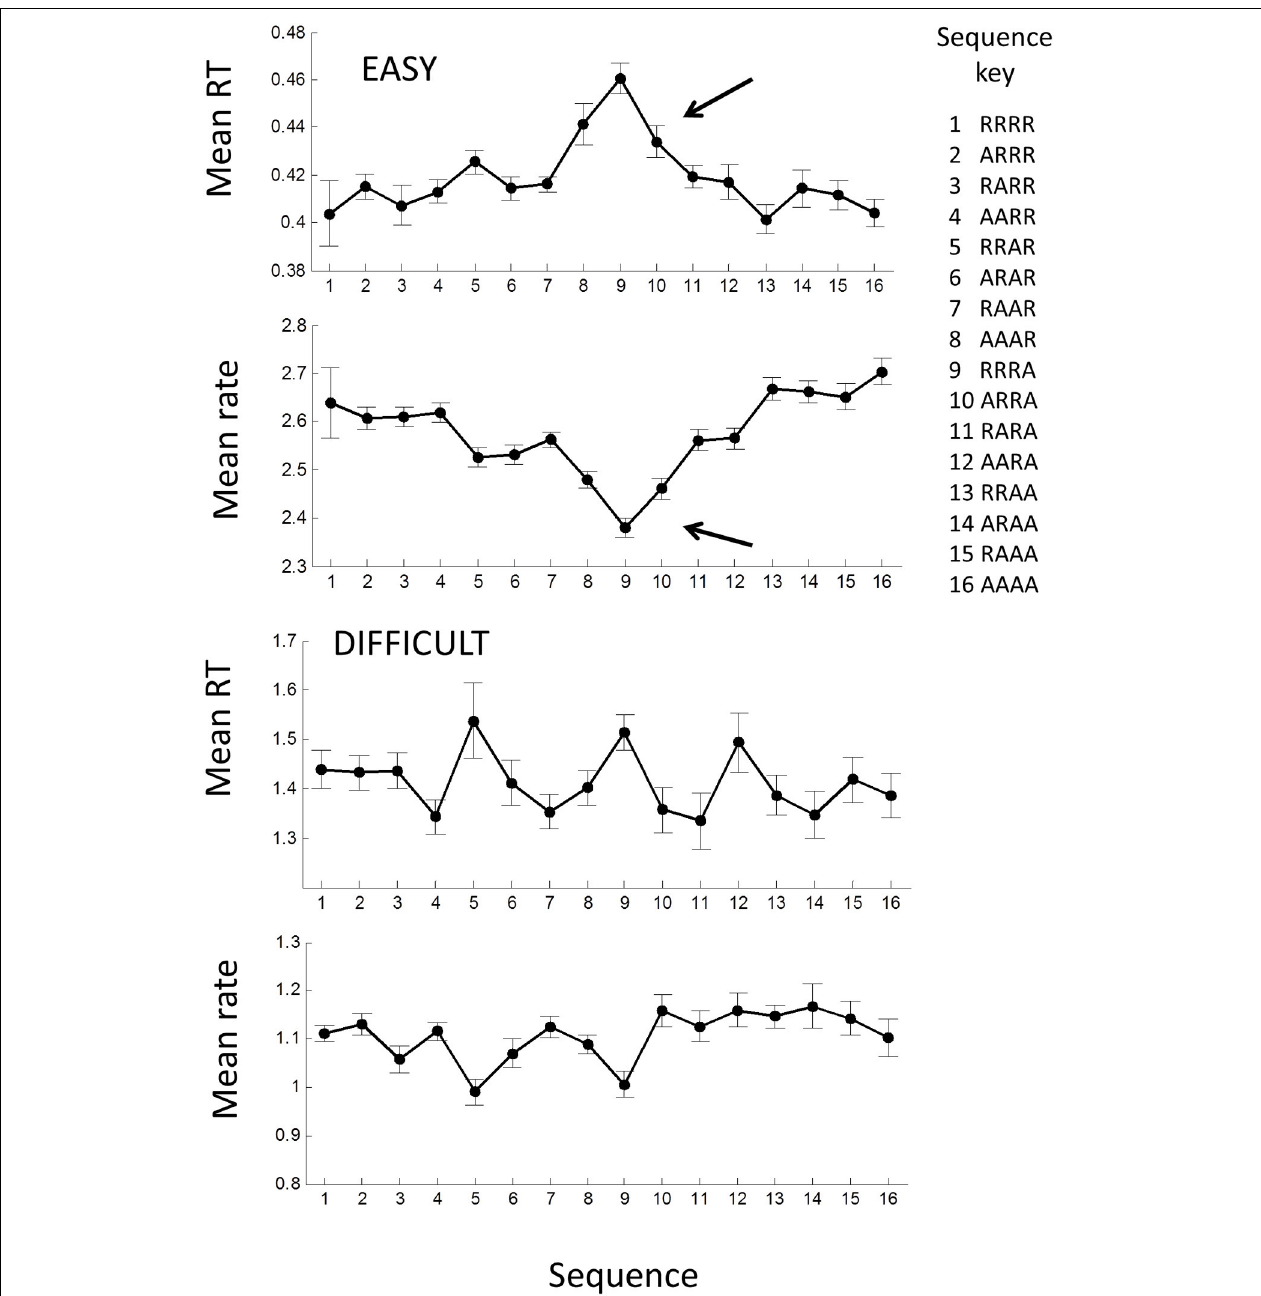
FIGURE 10 | Mean response time and rate plotted against the laterality sequence of previous 4 trials: R, laterality repeated; A, laterality alternated (after Jentzsch and Sommer, 2002). Means were computed